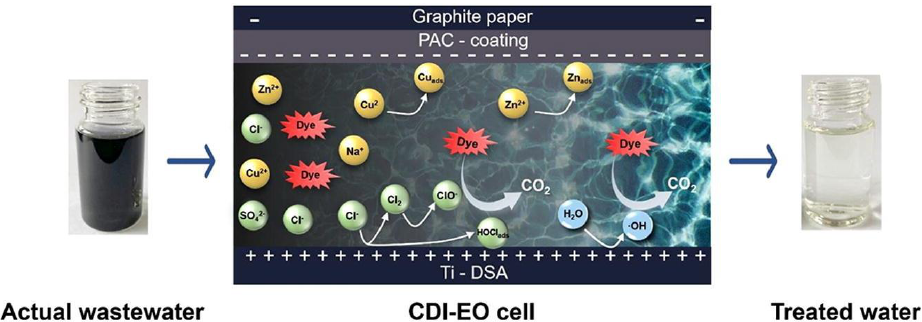
Figure 8. Removal process of Cu 2+ and Acid Orange 7 by CDI-EO system [141]. Copyright 2022, Elsevier.